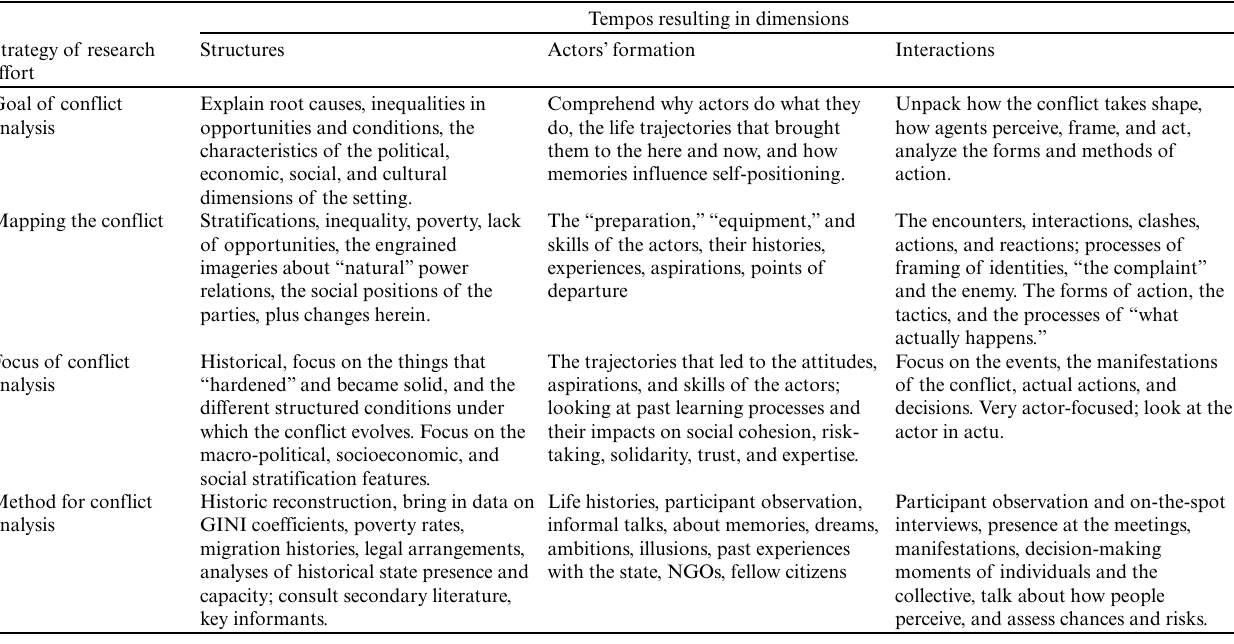
Table 1 . Scheme of dimensions and strategies for research design (adapted from Salman and de Theije